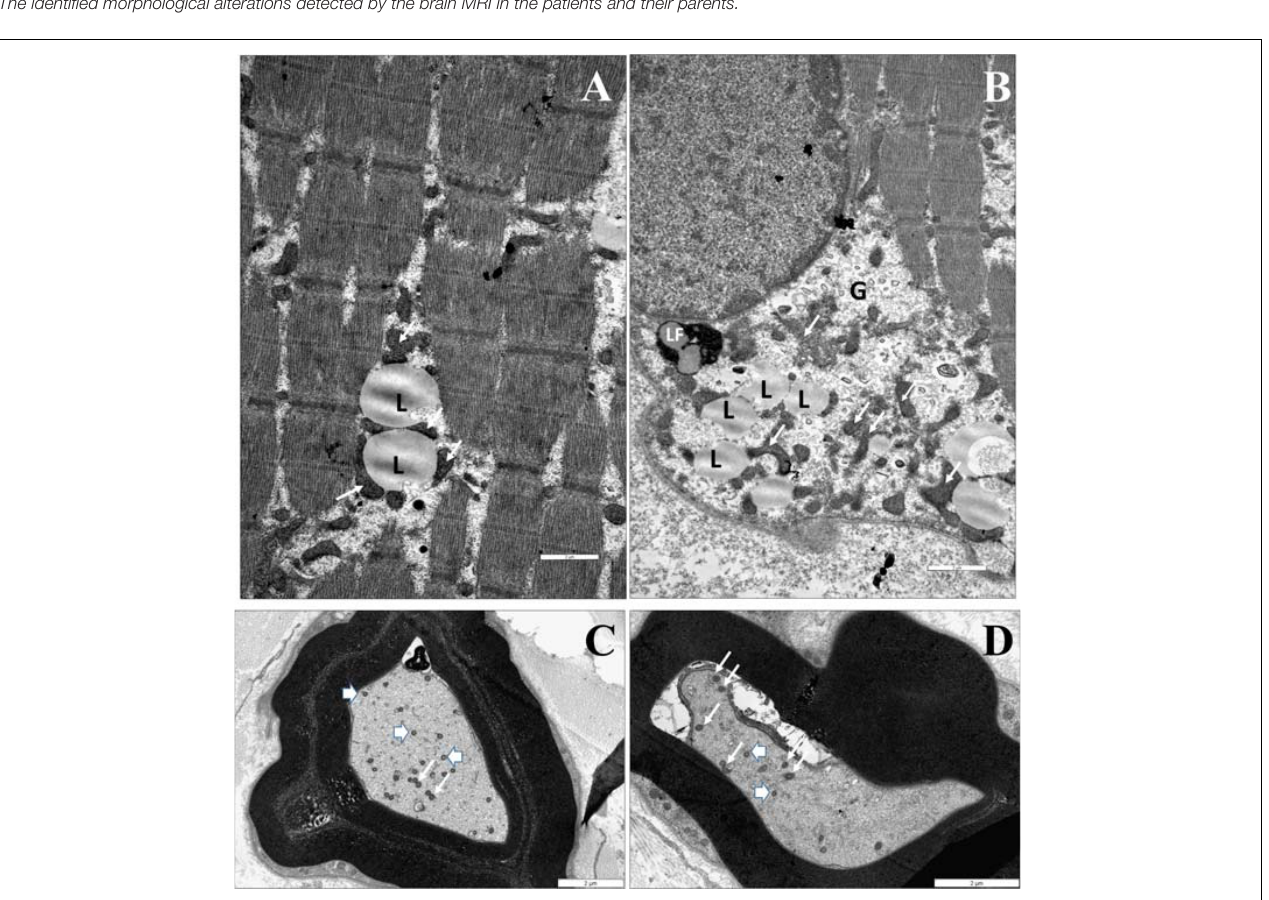
FIGURE 4 | The identified neuropathological alterations. Muscle biopsy of IV/2 proband (A,B) . (A) EM shows an accumulation of particular-shaped mitochondria and lipid vacuoles in the intermyofibrillar space (L: lipid vacuole, white arrow: mitochondrium). (B) The accumulation of lipid vacuoles and glycogen with slight mithocondrial proliferation in the subsarcolemmal area (L: lipid vacuole, LF: lipofuscin, G: glycogen, and white arrow: mitochondrium). Nerve biopsy of IV/2 proband (C,D) : (C) Slightly enlarged mitochondria an axon (white arrows: mitochondrion). The myelin is decompacted, (D) EM shows dystrophic axons: Tubulovesicular structures can be observed in the spheroid, as well as degenerated vesicles and vacuoles. Scale bars: 2 µ m (arrowhead: spheroid body).